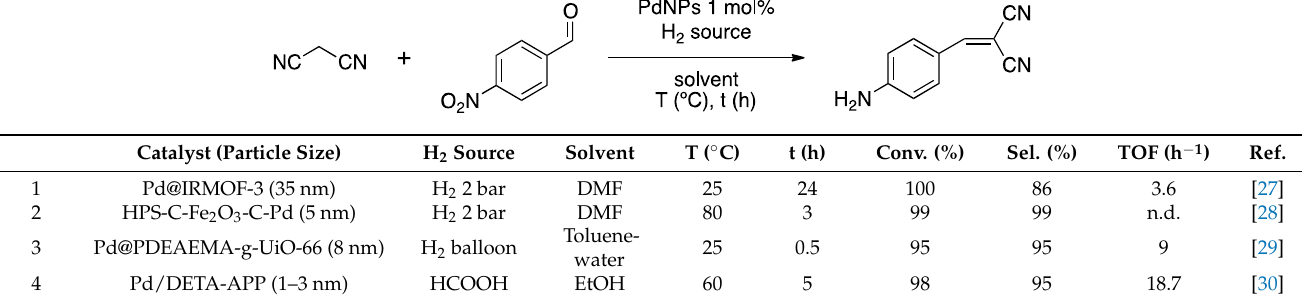
Table 2. Comparison of the reported catalytic activity to the sequential condensation/nitro reduction.